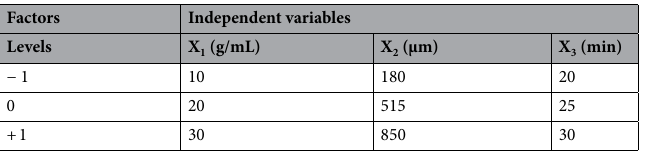
Table 1. The selected independent variables and coded values. Parameters: X 1 = solvent to solid ratio, X 2 = particle size, and X 3 =